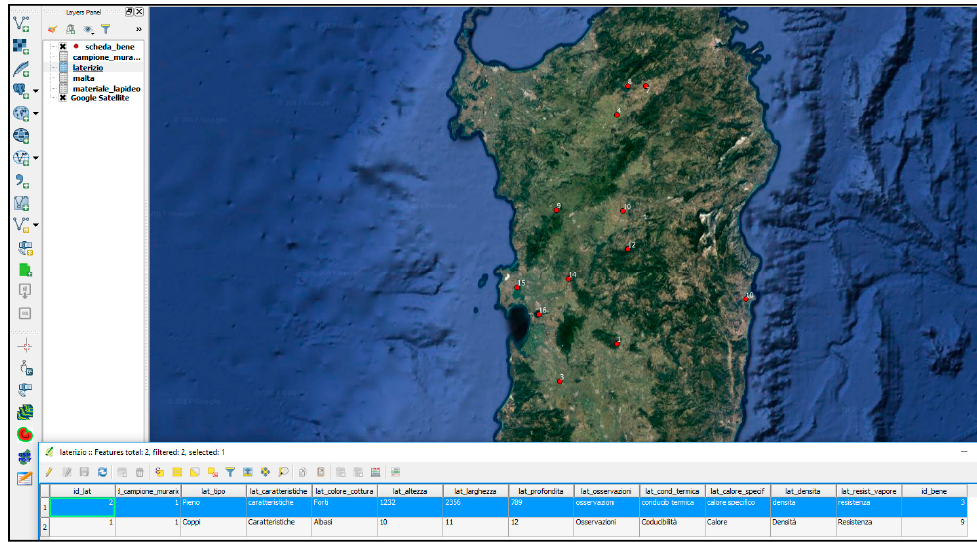
Figure 8. Quantum GIS (QGIS) project.